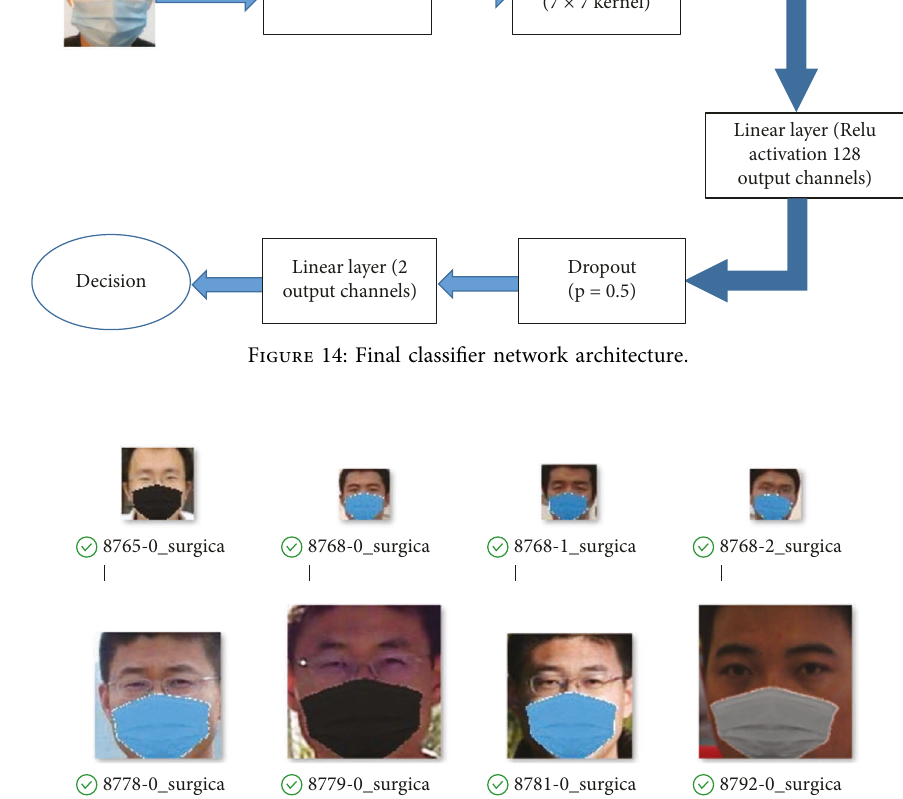
Figure 15: Images in our data set with different